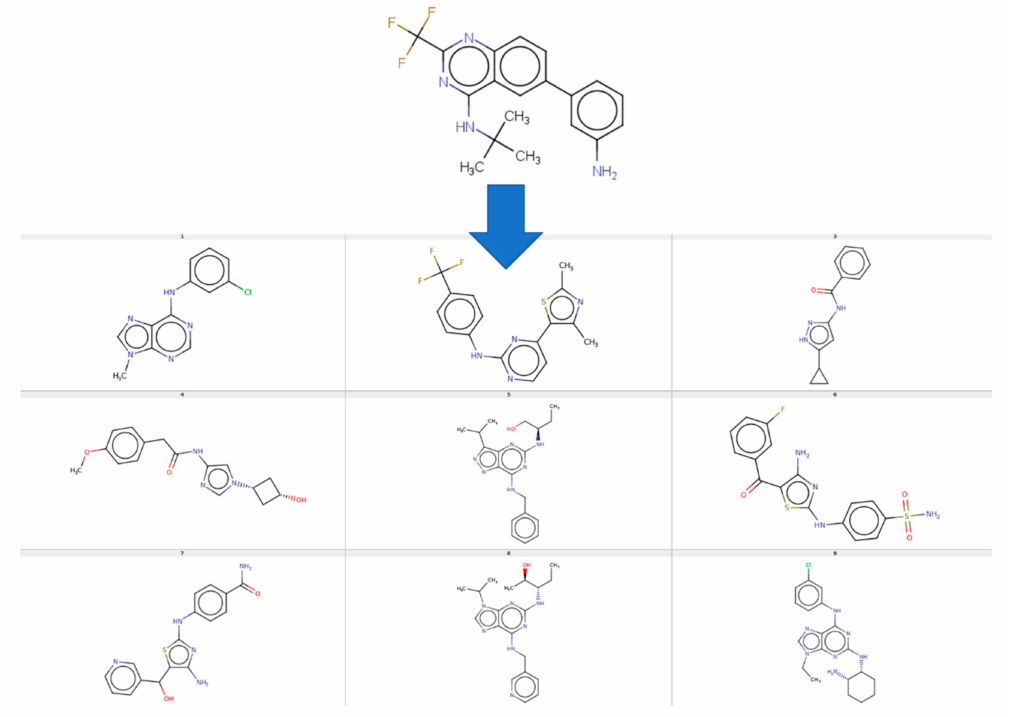
Figure 8. Structure of ligand 2B53, generating a RMSD landscape able to provide quantitative predictions for nine other–structurally not obviously related–ligands, shown below.